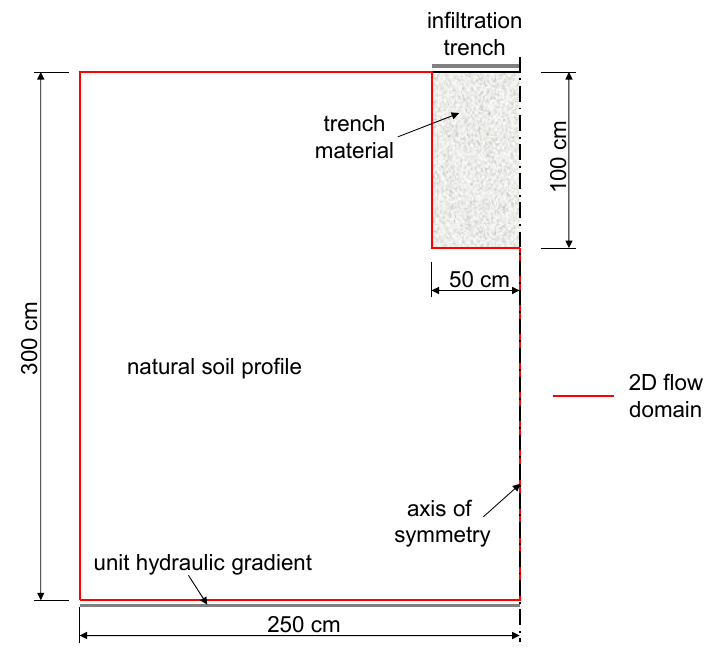
Figure 3. Schematic of the two-dimensional flow domain used for the simulations.